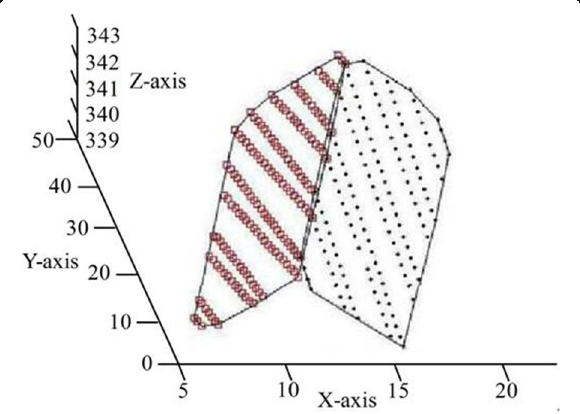
Fig. 3 Cluster distribution and fitting of plane